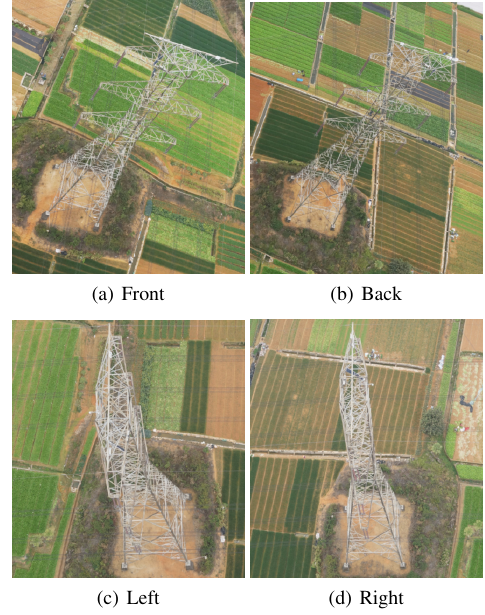
Figure 6. Images of one power pylon in four directions.